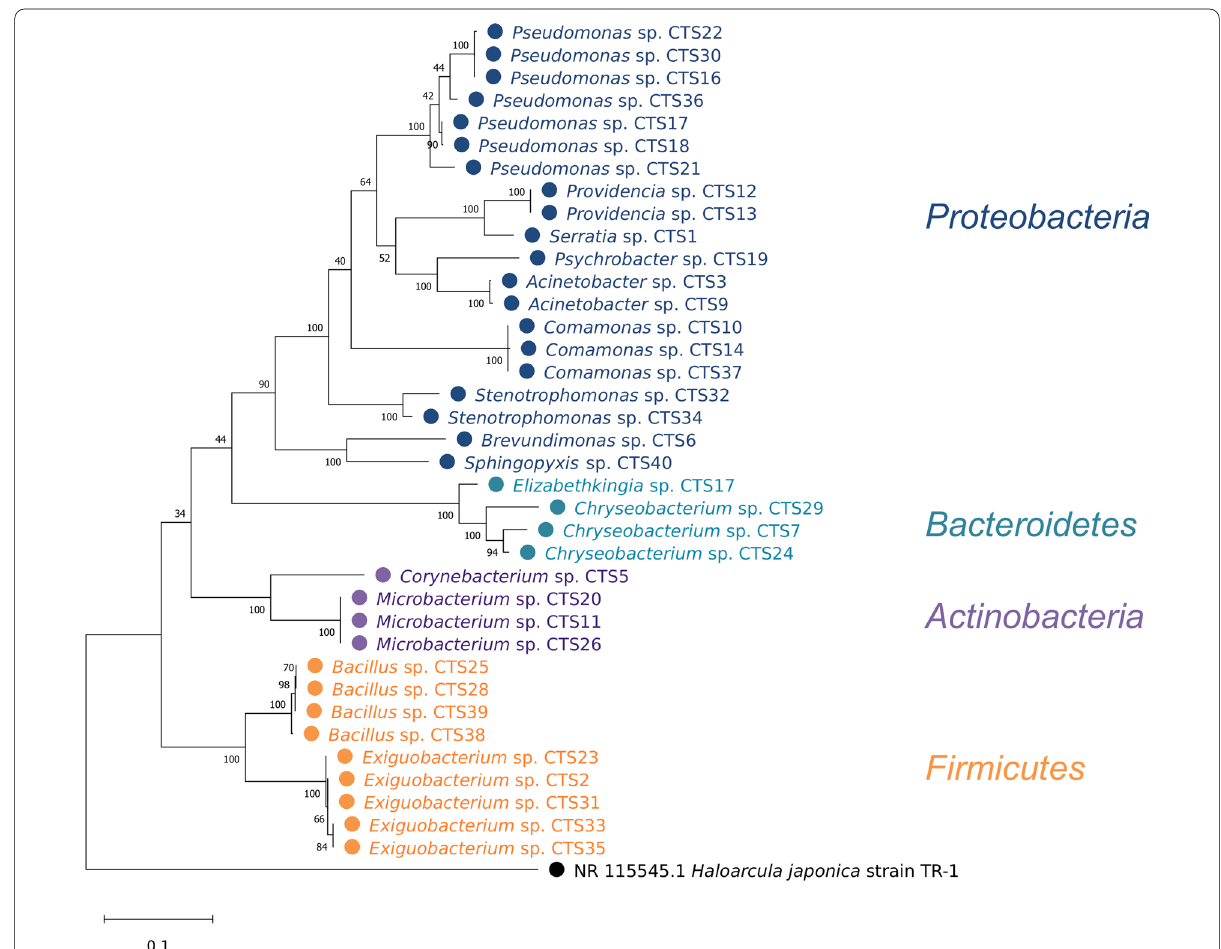
Fig. 1 Phylogenetic tree of the strains isolated from biofilm sample. Halocarcula japonica strain TR-1 (GenBank: NR115545.1) was set as the outgroup species. Bootstrap values are displayed at each